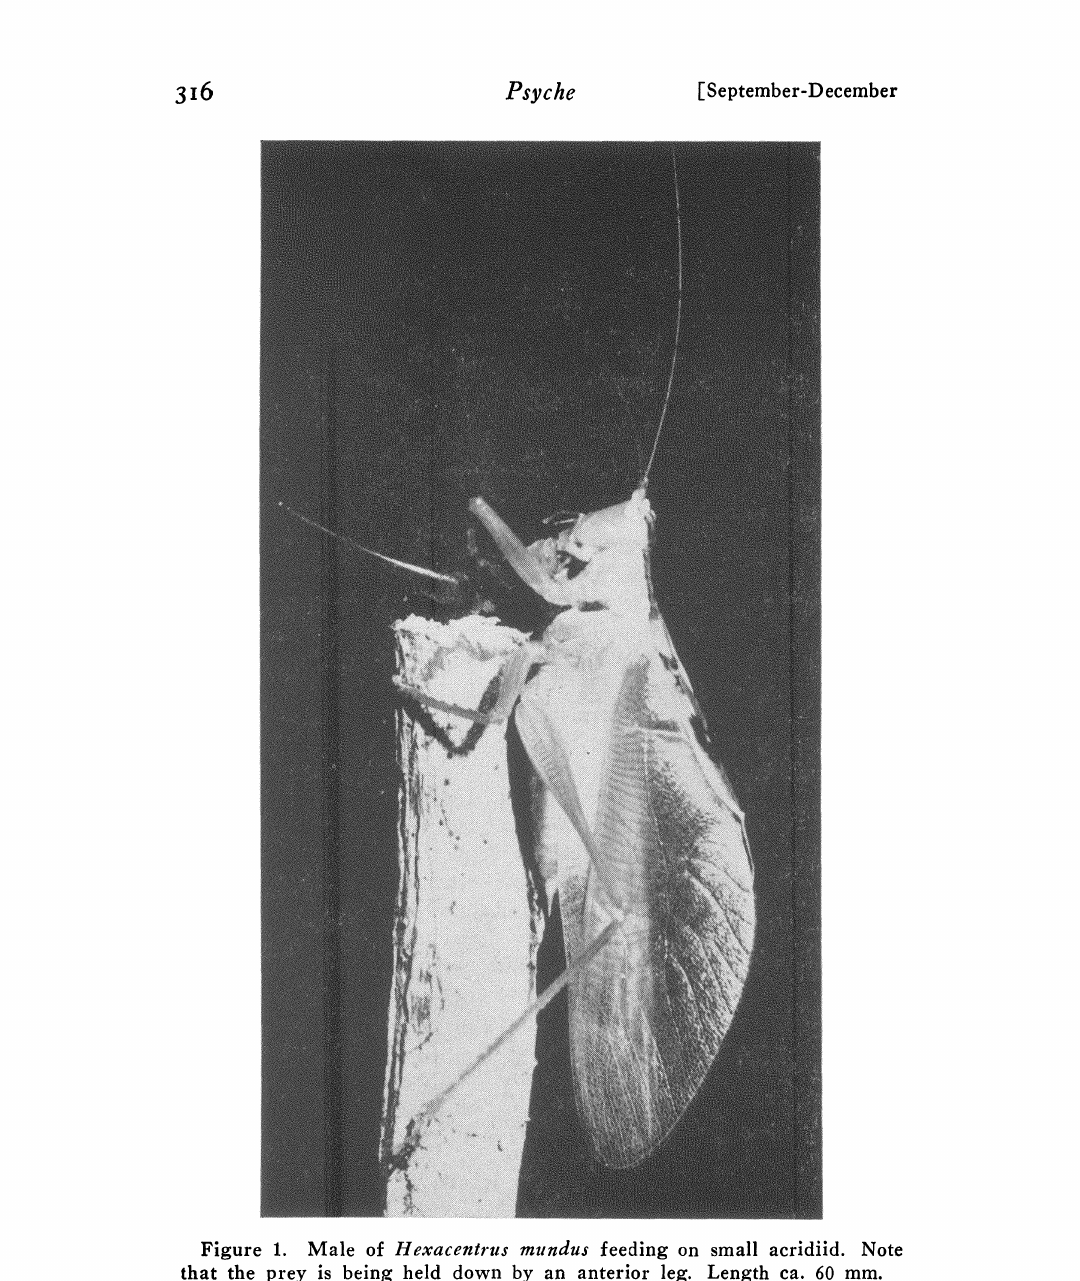
Figure 1. Male of Hexacentrus mundus feeding on small acridiid. Note that the prey is being held down by an anterior leg. Length ca. 60